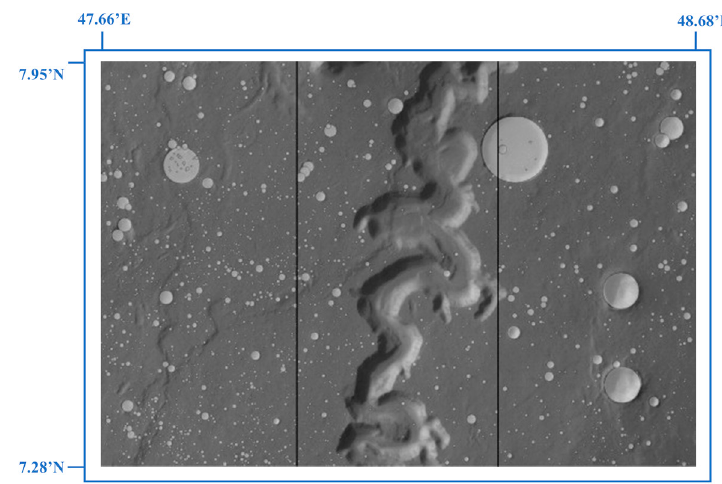
Figure A1. Banderia Mars Crater Database.